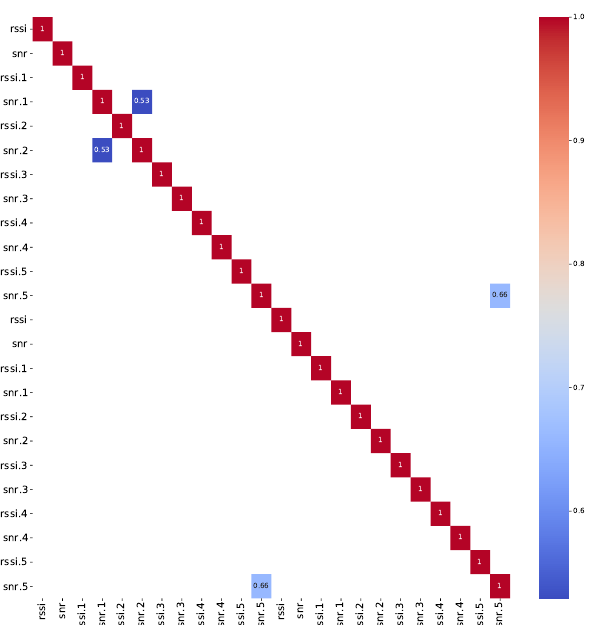
Figure 12. Data correlation for RSSI and SNR values for ROOM A509 and location points 9 and 11 for SF